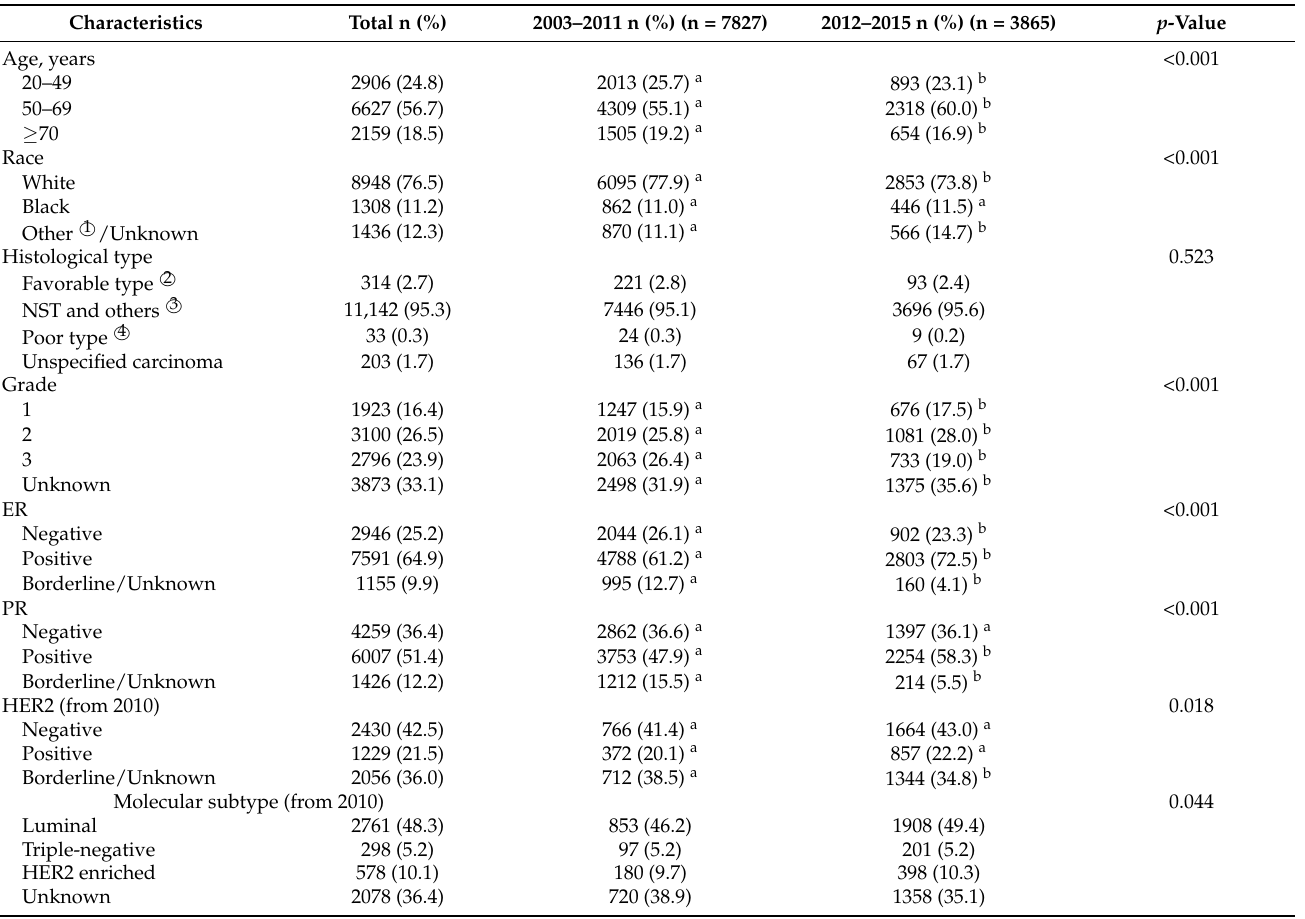
Table 1. Baseline demographic and clinicopathological characteristics of 11,692 microinvasive breast